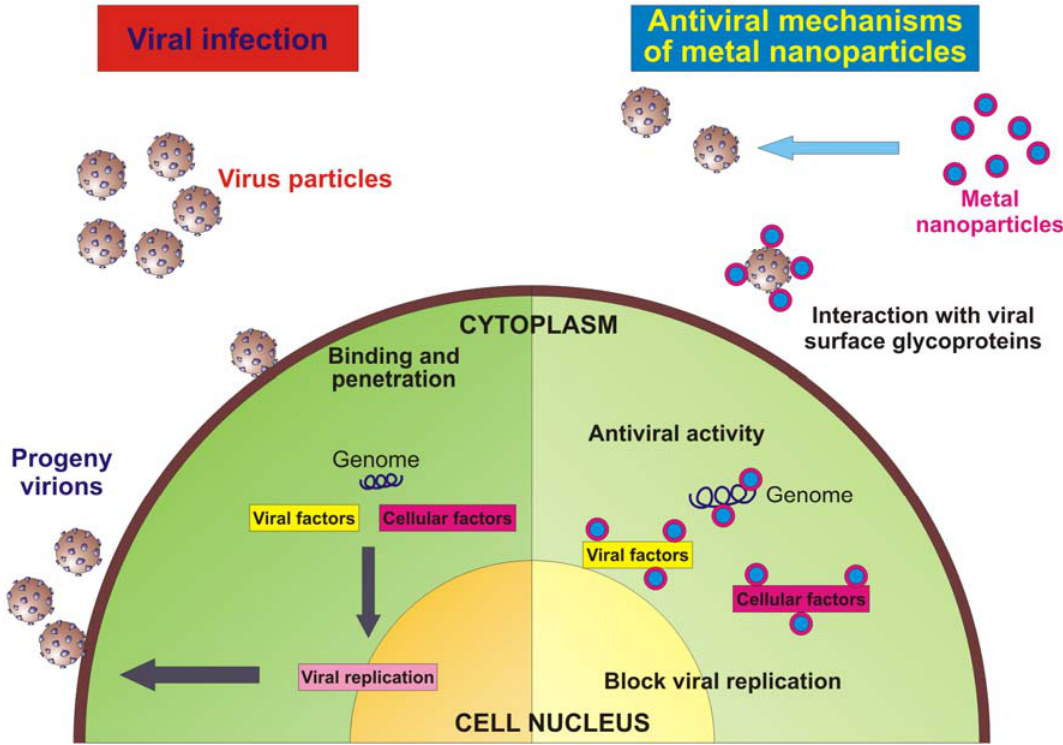
Figure 2. Schematic model of a virus infecting an eukaryotic cell and antiviral mechanism of metal